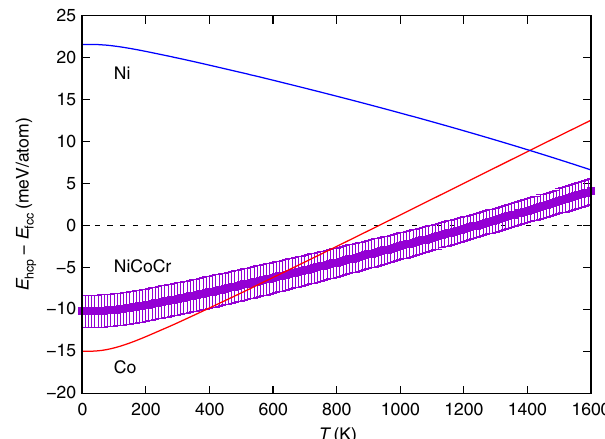
Fig. 2 Free energy difference between hcp and fcc phases as a function of temperature for Ni, Co and CrCoNi. The calculations are performed with DFT using quasi-harmonic approximation. The error bars for CrCoNi are standard errors of E hcp − E fcc , difference in average energies of each phase, calculated over six SQS cells with different random